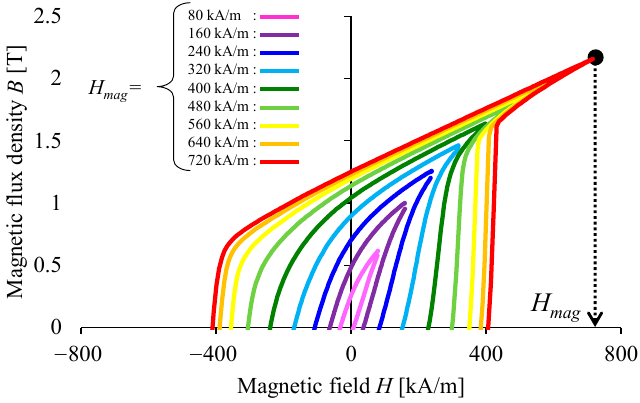
Figure 4. Measured B-H curves of NL720MC20.